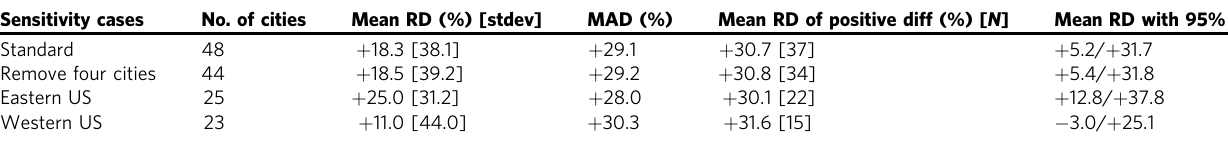
Table 2 Standard case and sensitivity of statistical results to removal of four cities with SRIs outside the 2010 – 2015 timespan of the Vulcan output (Columbus, OH: 2017; New Orleans: 2007; Longmont, CO: 2016; Salt Lake City, UT: 2009) and to the division of the Eastern US versus the Western US.